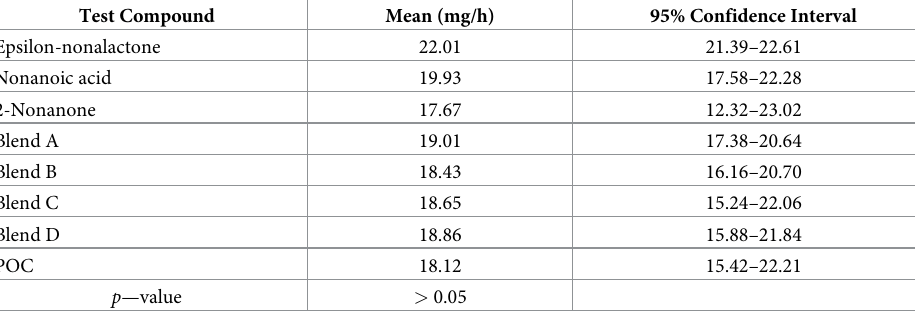
Table 2. Field release rate of odor compounds/blends from 150 microns